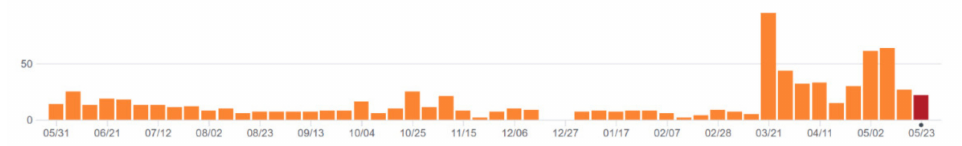
Figure 9. Popular content of COVID-19 data repository for past 14 days.